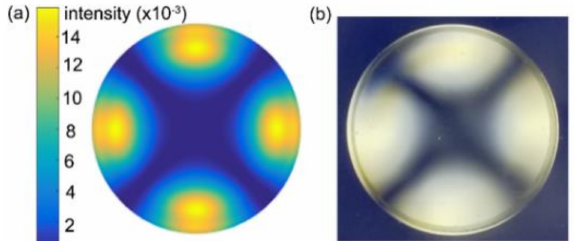
Figure 12. The birefringence optical retardation contours of the embossed glass from simulation ( a ) and experimental measurement ( b